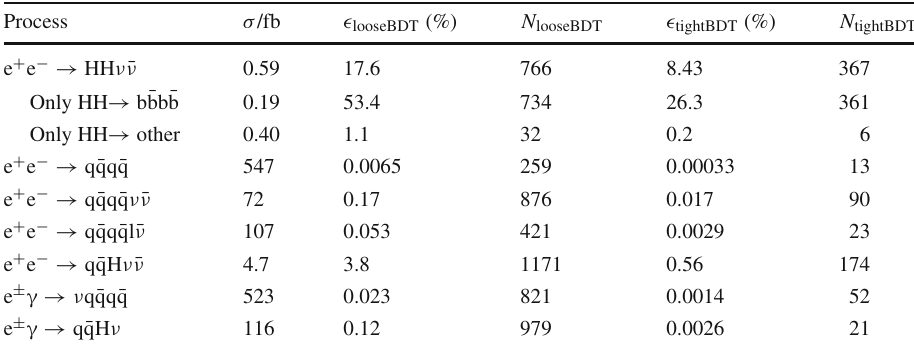
Table 4 Cross sections, σ , selection efficiencies, (cid:14) looseBDT ( (cid:14) tightBDT ), and expected number of events in the loose (tight) BDT selection region of the HH → b ¯ bb ¯ b analysis, N looseBDT √ s = 3TeV for ( N tightBDT ), at L = 5ab − 1 . The cross sections are for unpolarised beams; the numbers of events assume